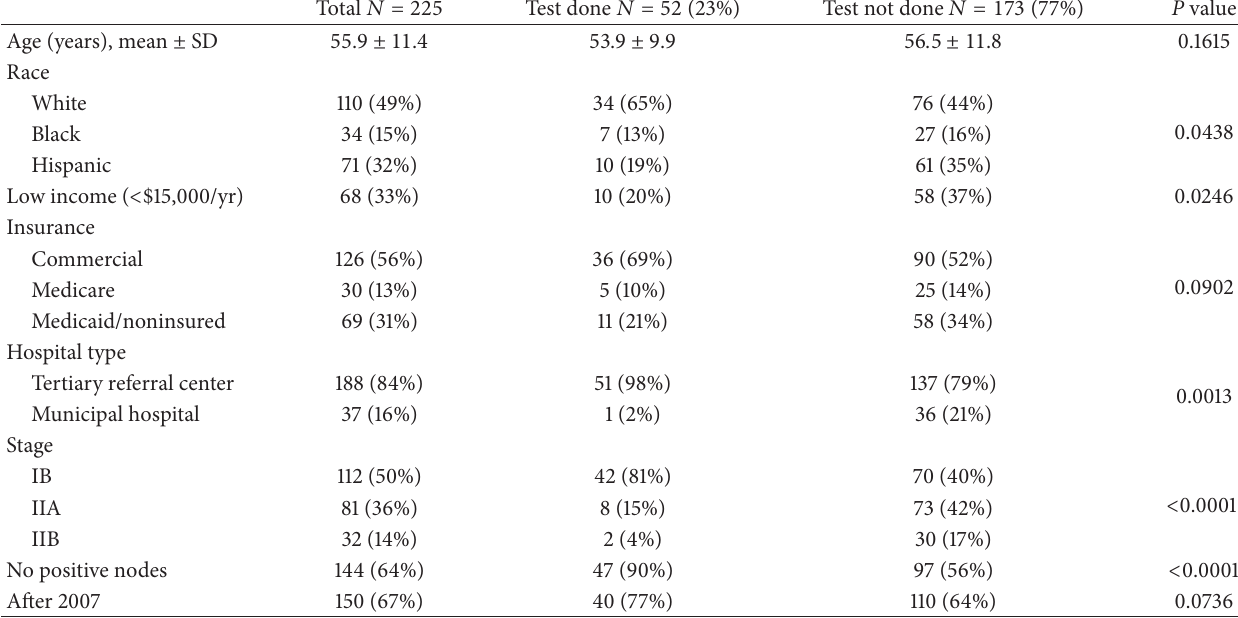
Table 1: Patient characteristics of women ODX tested versus not